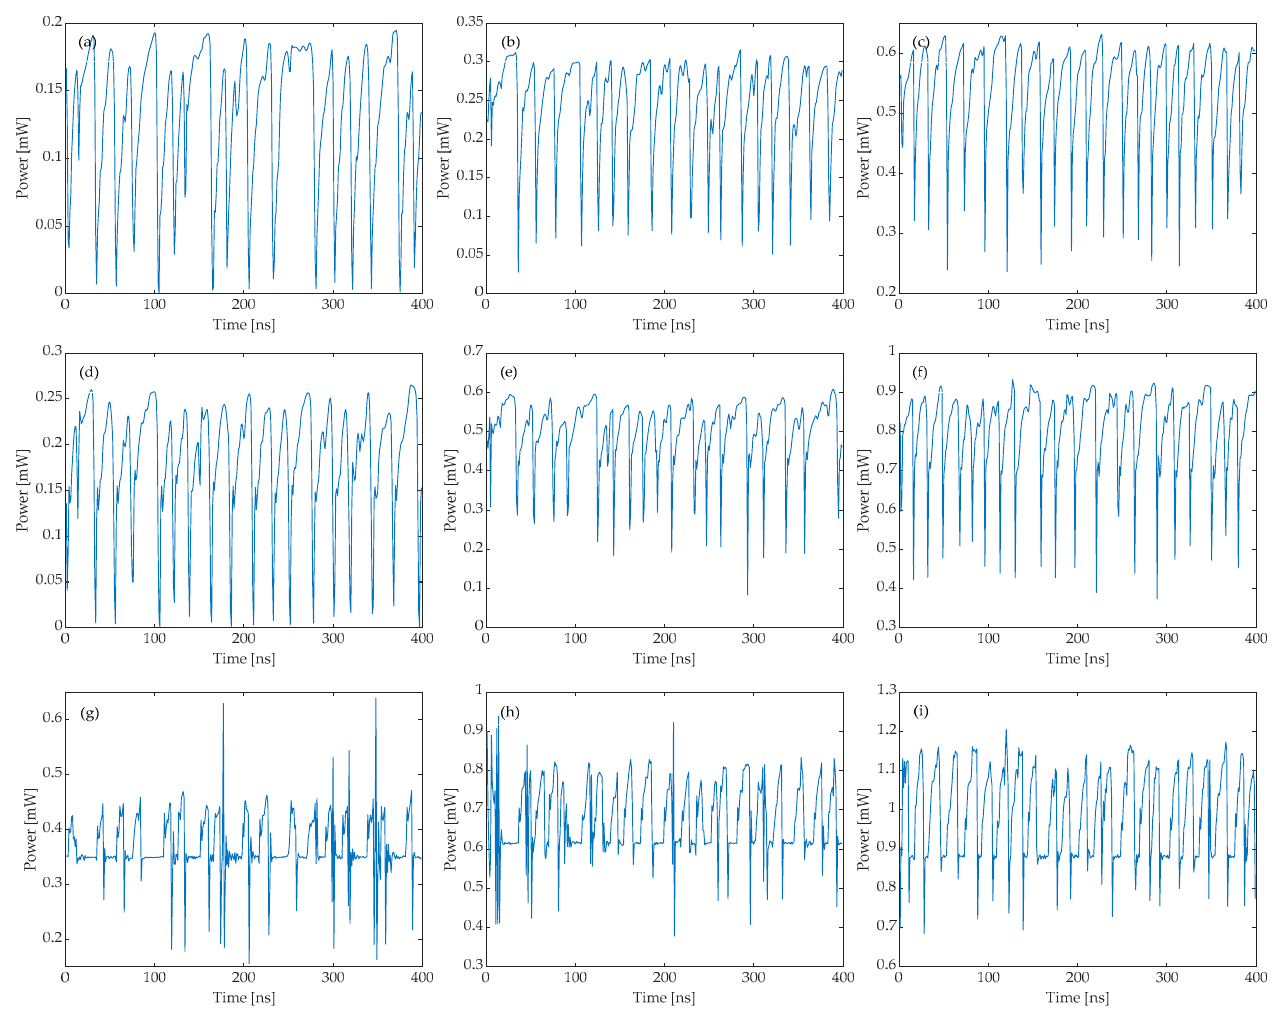
Figure 4. Output of response laser under different pump currents. κ D = κ R = 50 ns − 1 . Left column: I D = 15 mA. Middle column: I D = 16 mA. Right column: I D = 17 mA. ( a – c ): I R < I D . ( d – f ): I R = I D . ( g – i ): I R > I D